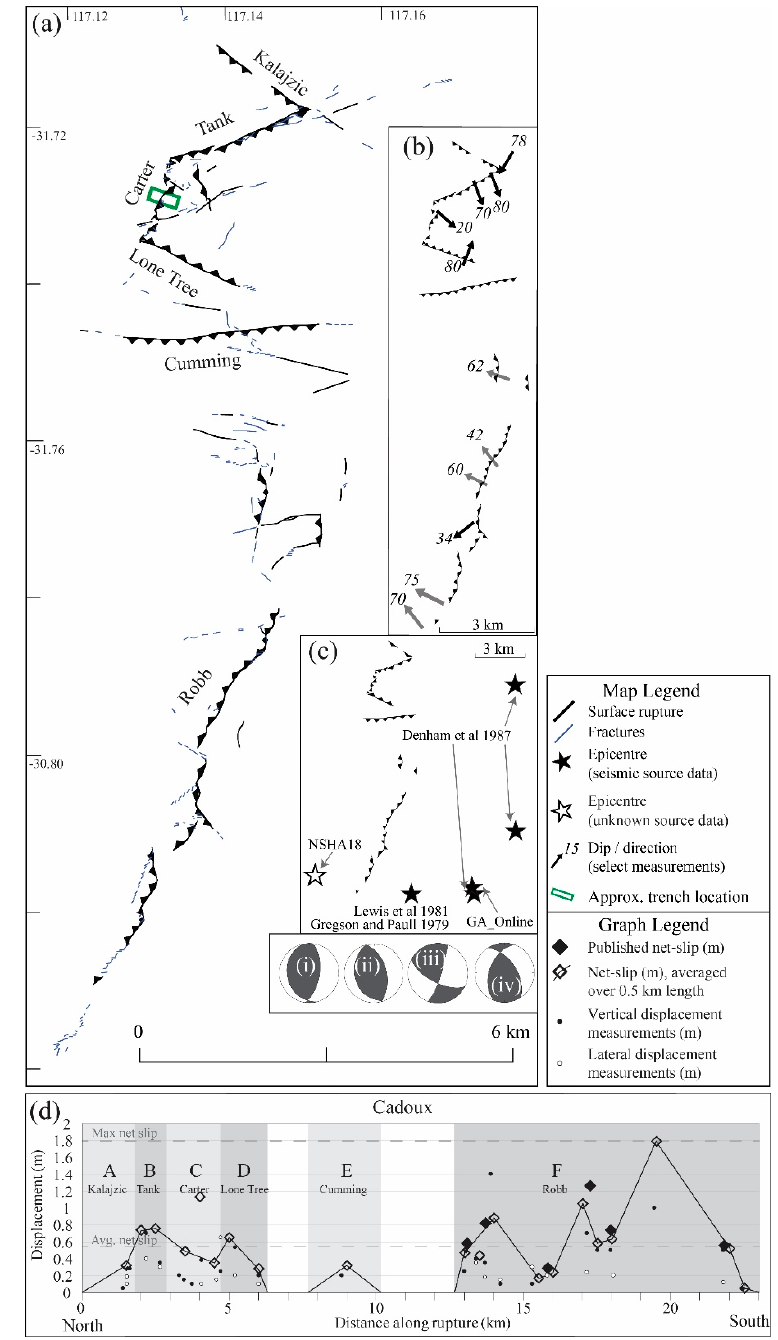
Figure 5. 1979 Mw 6.1 Cadoux earthquake ( a ) rupture scarps and fracturing involved in the Cadoux rupture with named faults [41], focal mechanisms from (i) Denham et al., 1987 (ii) Fredrich et al., 1988 (iii) Everingham and Smith (unpublished, Lewis et al., 1981) (iv) CMT ( b ) available dip measurements, black where directly measured and grey were calculated based on available displacement measurements [41] ( c ) published epicenter locations ( d ) graph along-rupture of vertical and lateral displacement measurements and calculated net slip [41] and net slip calculated from available data averaged over 0.5 km increments (this study). The corrected net-slip values for the Cadoux earthquake are: